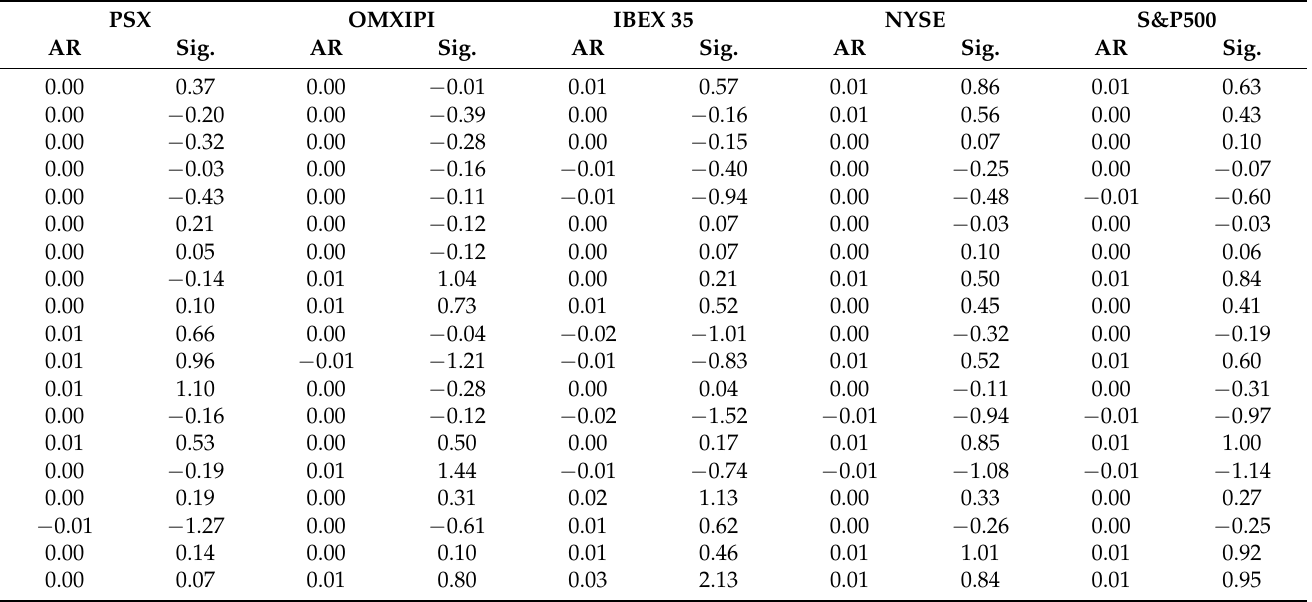
Table A31. Abnormal returns of the ( − 20, +20) event window (Resignation of D. Jos é Manuel Soria, Spain’s Minister of